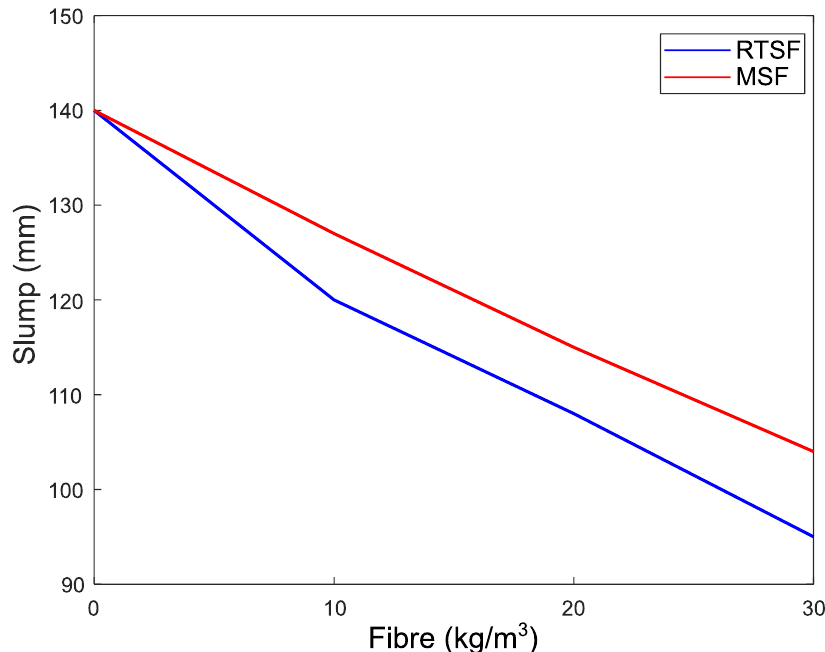
Figure 13. Effect of fibre type and dosage on slump of concrete.